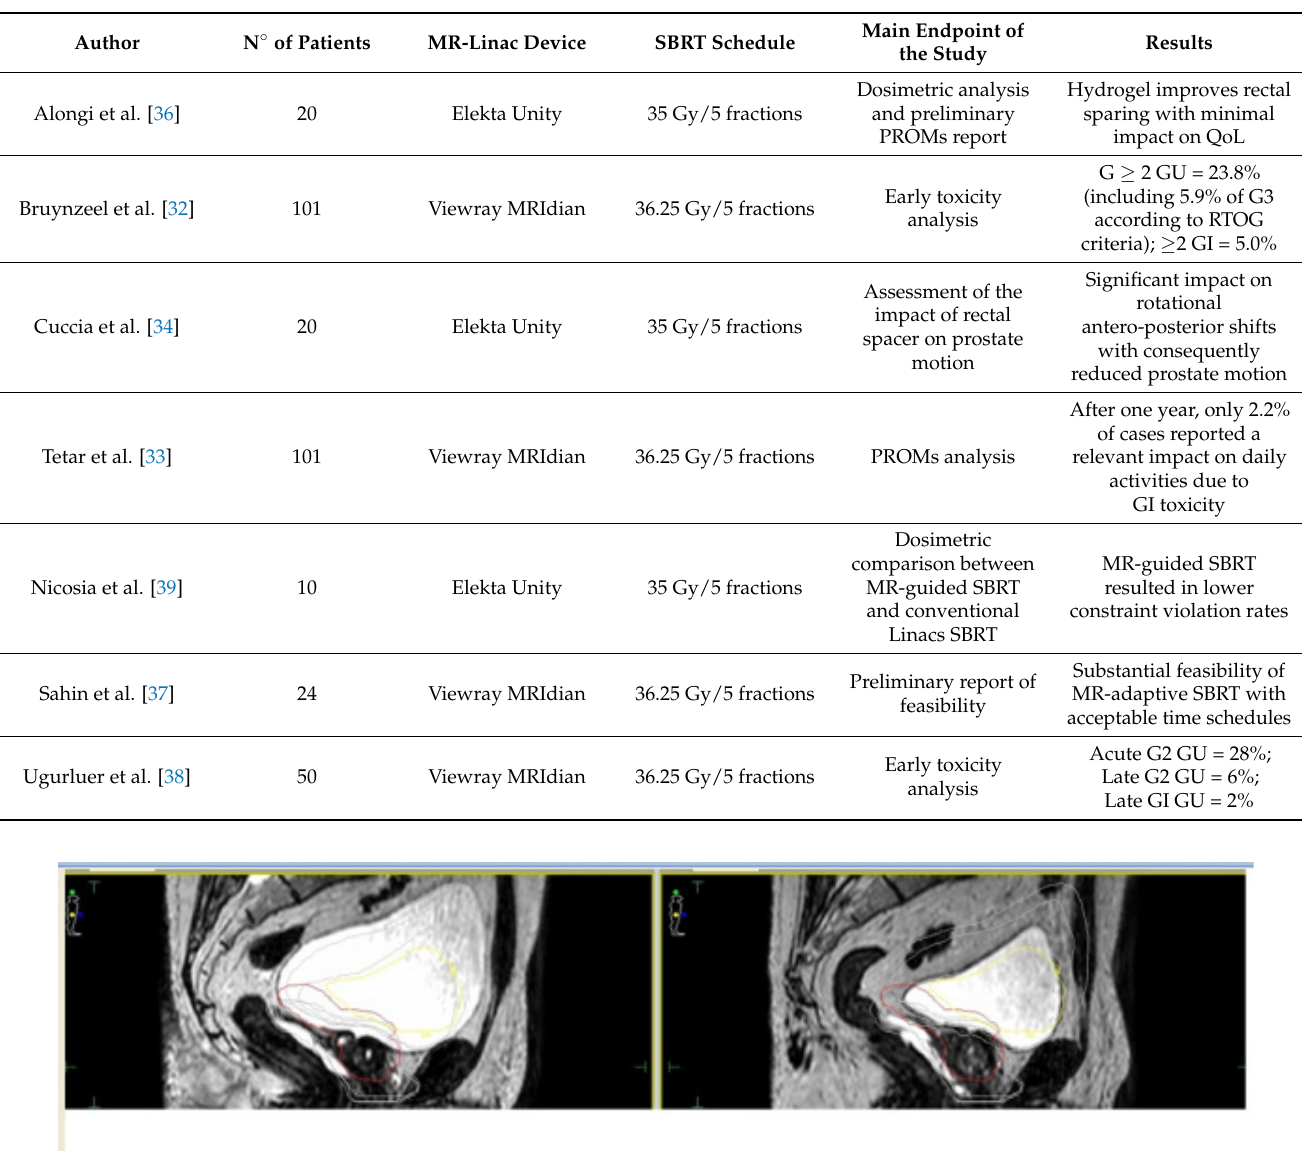
Table 1. Literature experiences of MR-guided daily adaptive SBRT for prostate cancer.